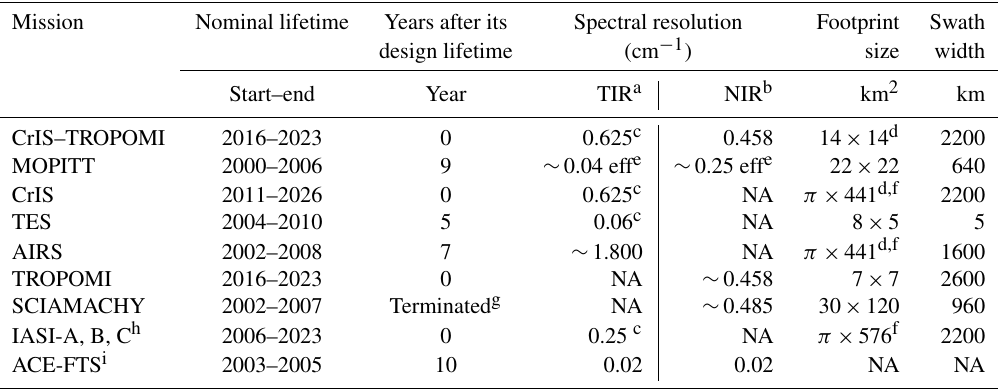
Table 1. Satellite missions that measure tropospheric carbon monoxide. Mission Nominal lifetime Years after its Spectral resolution Footprint Swath design